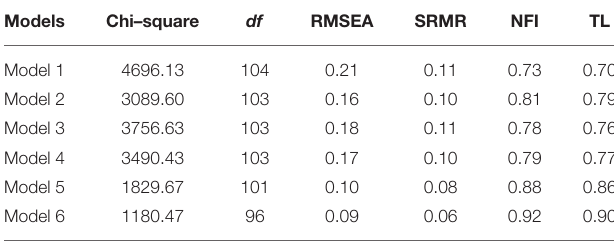
TABLE 6 | Assessment of fit of the STCI–T < 106 > data. TABLE 7 | Standardized coefficients for Model